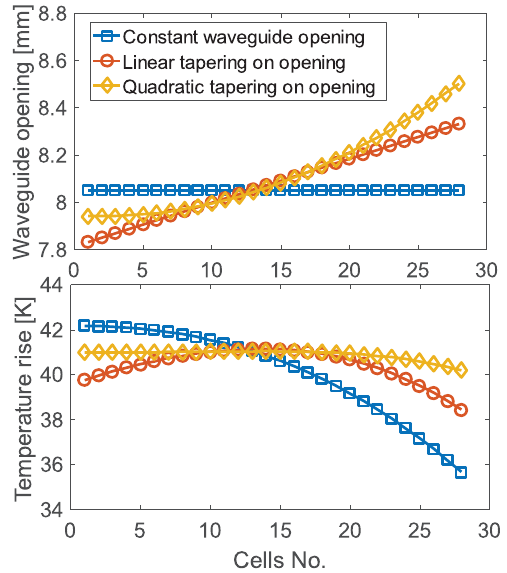
FIG. 12. Tapering on waveguide openings and corresponding temperature rise distributions.